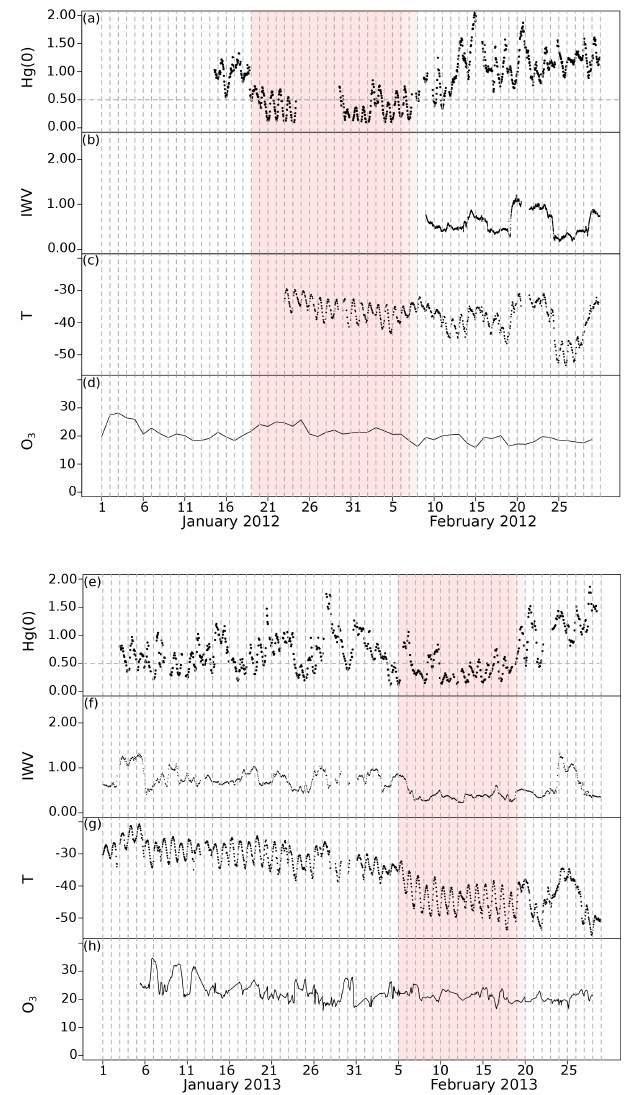
Figure 6. Top: January and February 2012 cycle of (a) hourly av- eraged Hg(0) concentrations (in ngm − 3 ) at 500cm above the snow surface, (b) integrated water vapor (IWV, kgm − 2 ), (c) temperature (in ◦ C) at 10m above ground level, and (d) ozone (O 3 , daily mean) mixing ratios (ppbv). Hg(0) was low from 19 January to 8 Febru- ary (period highlighted in red) while O 3 showed no abnormal vari- ability. Bottom: January and February 2013 cycle of the following: (e) hourly averaged Hg(0) concentrations (in ngm − 3 ) at 210cm above the snow surface, (f) integrated water vapor (IWV, kg m − 2 ), (g) temperature (in ◦ C) at 10m above ground level, and (h) ozone (O 3 , hourly mean) mixing ratio (ppbv). Hg(0), IWV, and temper- ature were low from 5 to 20 February (period highlighted in red) while O 3 showed no abnormal variability. Note that Hg(0) concen- trations exhibited the same pattern at the three inlets of the meteo- rological tower from 5 to 20 February